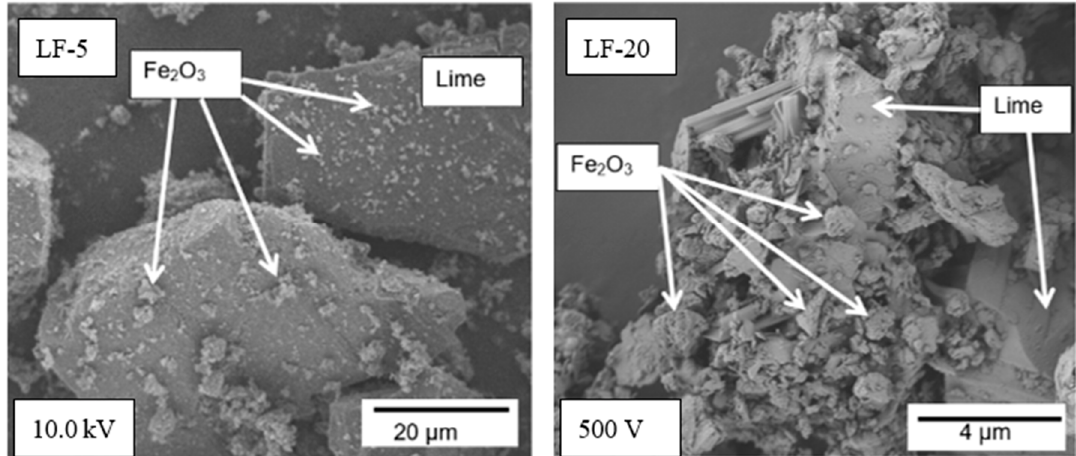
Figure 6. SEM images of the microstructure of mortars with 5% and 20% of Fe 2 O 3 particles (LF-5 and LF-20, respectively), showing spatial distribution of lime and iron (III) oxide particles.